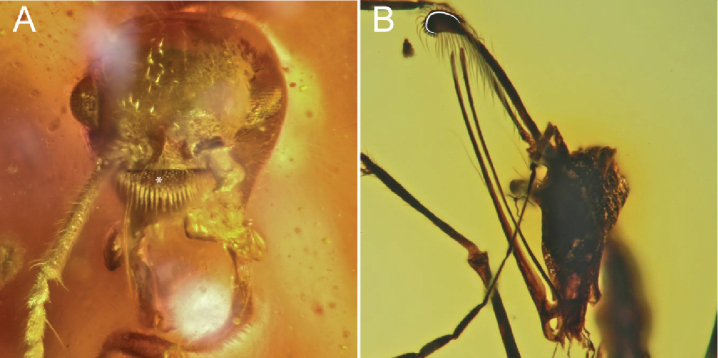
Facial seta and chaeta arrays of trigger-hair-bearing †HaidomyrmecinaeA †Haidomyrmex
cerberus, holotype worker, dorsolateral oblique (BMNHP20182, AntWeb: Vincent Perrichot) B †Ceratomyrmex
ellenbergeri, worker, dorsal anterolateral oblique (FANTWEB00005, AntWeb: Vincent Perrichot).